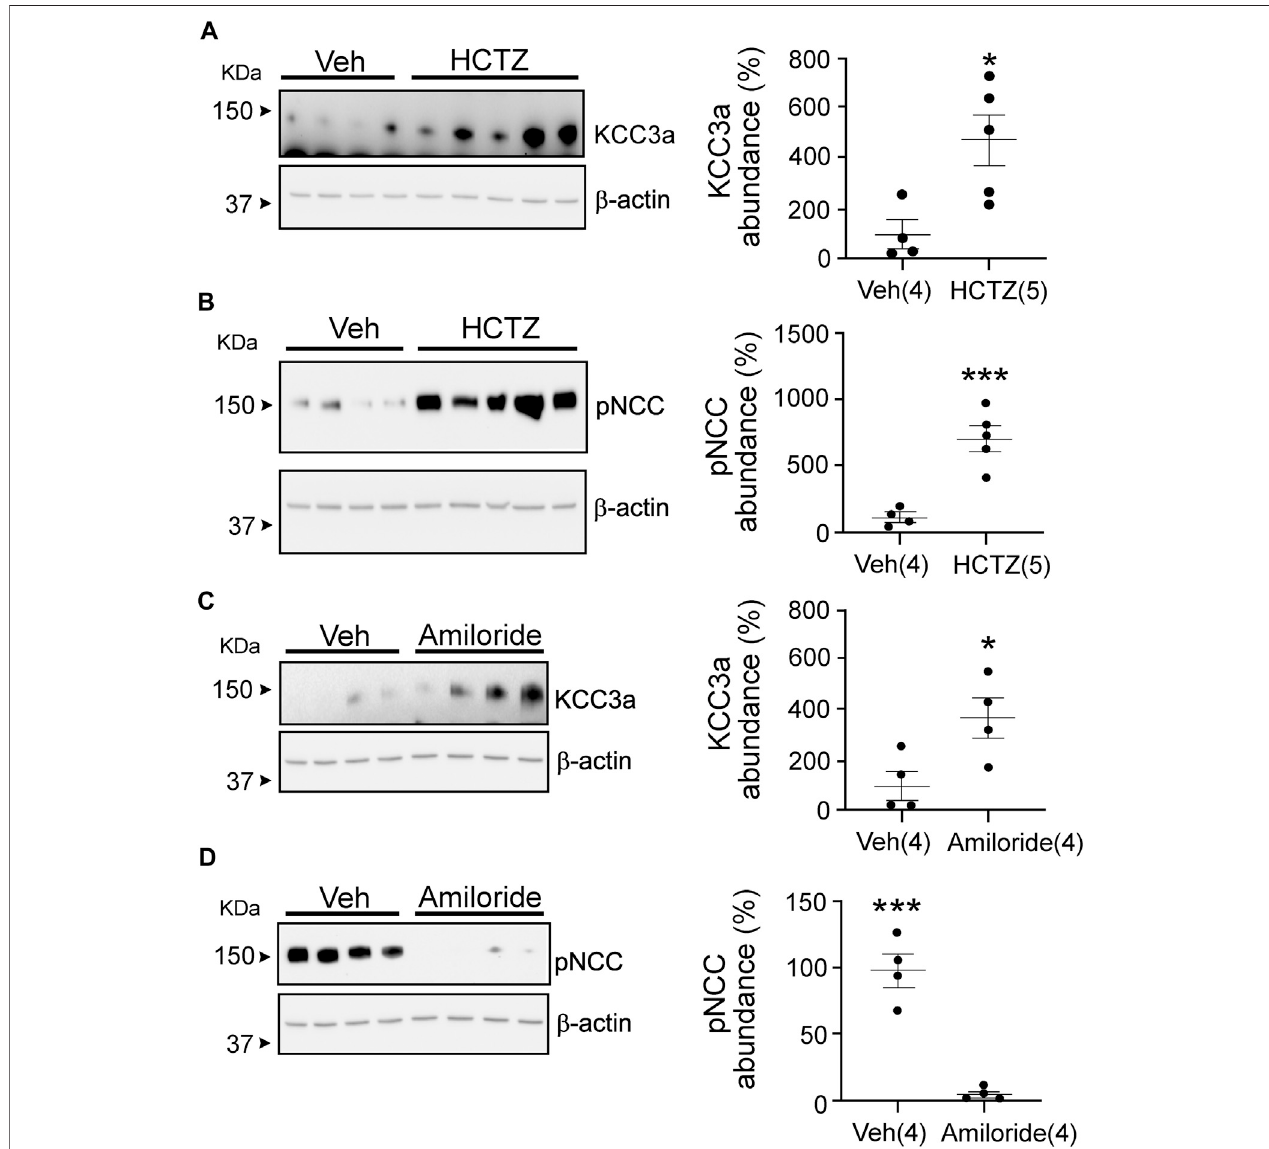
FIGURE 5 | Potassium chloride cotransporter 3a (KCC3a) abundance changes in response to hydrochlorothiazide (HCTZ) treatment. (A) KCC3a abundance increases after HCTZ (37.5 mg/kg body weight) treatment compared with the vehicle (Veh, glycol:water = 300:100)-treated group (two-tailed unpaired t -test). (B) After HCTZ treatment, compared with the Veh-treated mice, the abundance of phosphorylated sodium chloride cotransporter (pNCC) increases (two-tailed unpaired t -test), demonstratingthedrug ’ seffectiveness. (C) TheabundanceofKCC3ainamiloride-treatedmicewashigherthaninvehicle-treatedmice(two-tailedunpaired t -test). (D) In mice treated with vehicle, the abundance of pNCC was lower than in mice treated with amiloride (two-tailed unpaired t -test). For blot quanti fi cation, densitometric values were normalized to β -actin. Values are means ± SEM; values in parentheses indicate n values. * p < 0.05; *** p < 0.001.